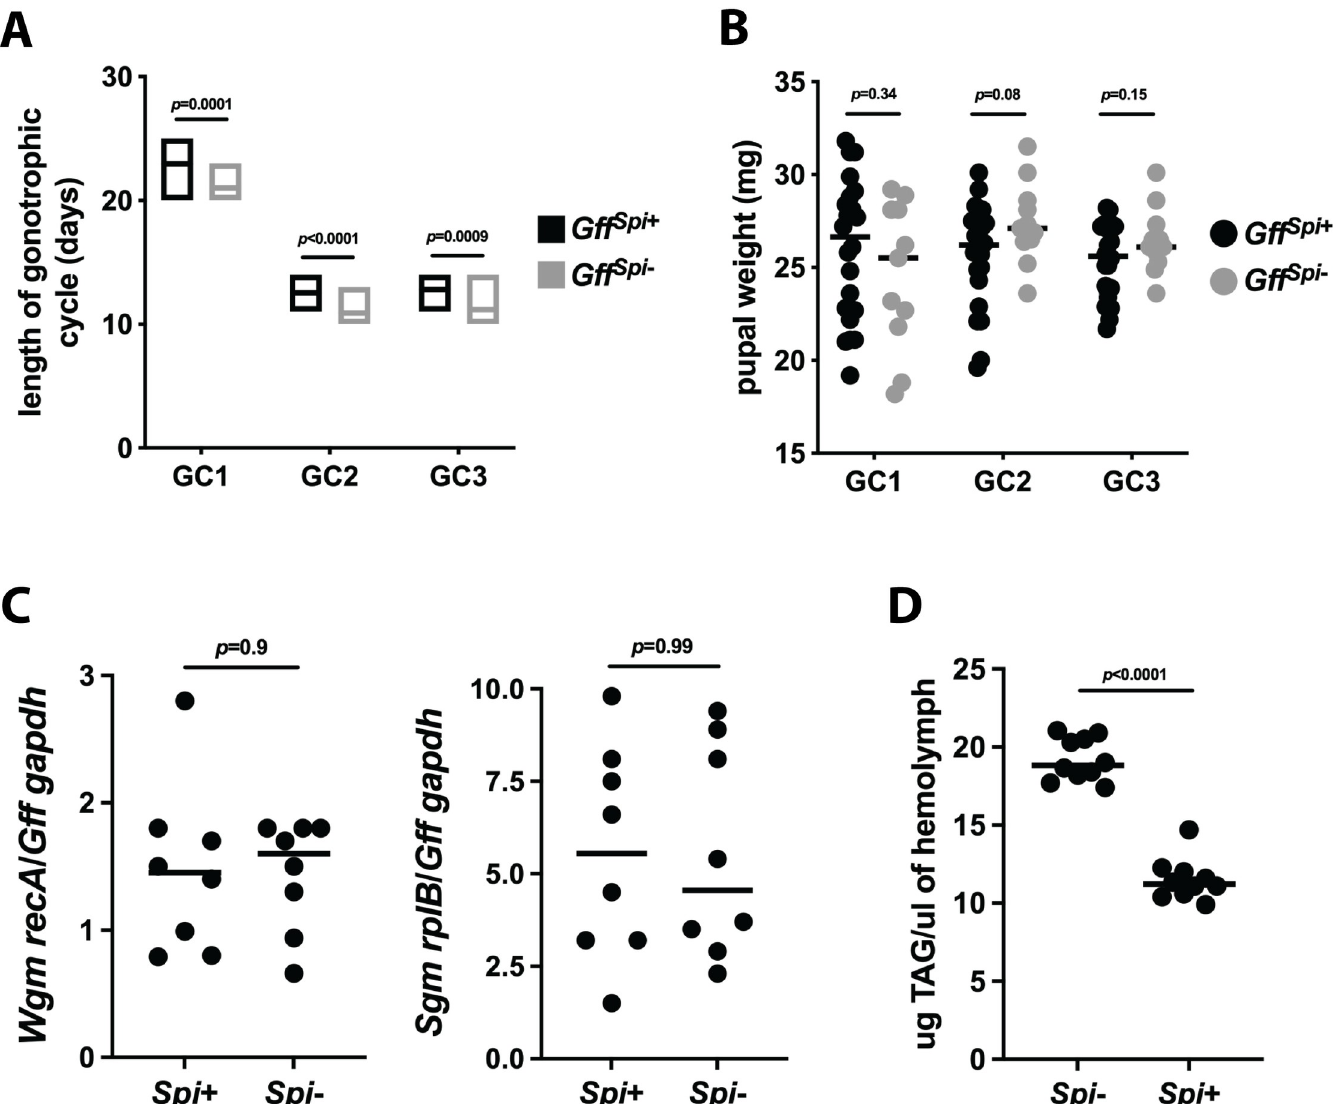
Fig 3. Impact of Spiroplasma infection on the reproductive and nutritional fitness of female tsetse flies. (A) Gonotrophic cycle (GC) length of offspring from Gff Spi+ and Gff Spi- females. Age-matched, pregnant females from each group ( n = 34 per group) were housed in individuals cages and monitored daily to observe frequency of pupal deposition. Statistical significance was determined via log-rank test. (B) The weight of pupae deposited by Gff Spi+ and Gff Spi- females. Each dot represents an individual pupa, bars represent median values of pupae form each GC. Statistical significance was determined via multiple t-tests with correction via the Holm-Sˇı´da´k method. (C) Relative densities of Wigglesworthia and Sodalis in Gff Spi+ and Gff Spi- females. Relative Wigglesworthia recA and Sodalis rplB copy number was quantified using genomic DNA derived from Gff Spi+ or Gff Spi- female midguts (including the Wigglesworthia harboring bacteriome organ). Wigglesworthia recA and Sodalis rplB was normalized relative to Gff gapdh copy number in each sample. Each dot represents one biological replicate (three midguts per replicate), and bars indicate median values. Statistical significance was determined via students t-test. (D) Amount of triacylglyceride (TAG) circulating in the hemolymph of Gff Spi+ and Gff Spi- females. Three microliters of hemolymph was extracted from two-week-old pregnant females and TAG was quantified colorimetrically via comparison to triolein standard curve (S2 Fig). Each dot represents an individual pupa, bars represent median values of pupae form each GC. Statistical significance was determined via unpaired t-test.